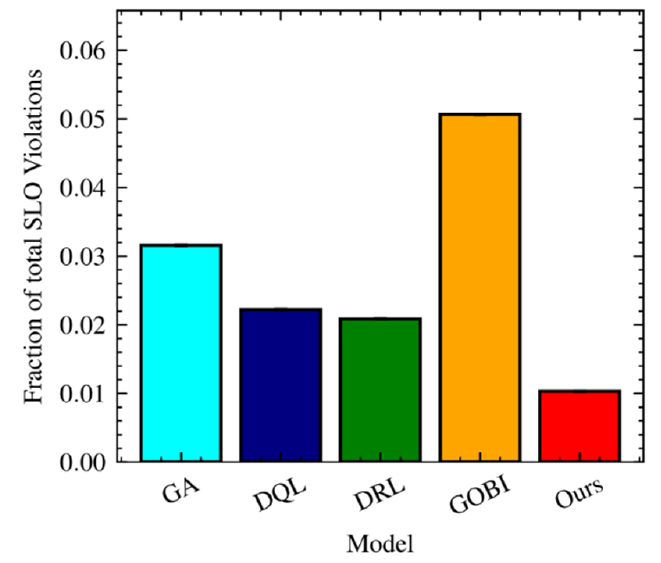
Figure 6. Service level objective violations with ten hosts.